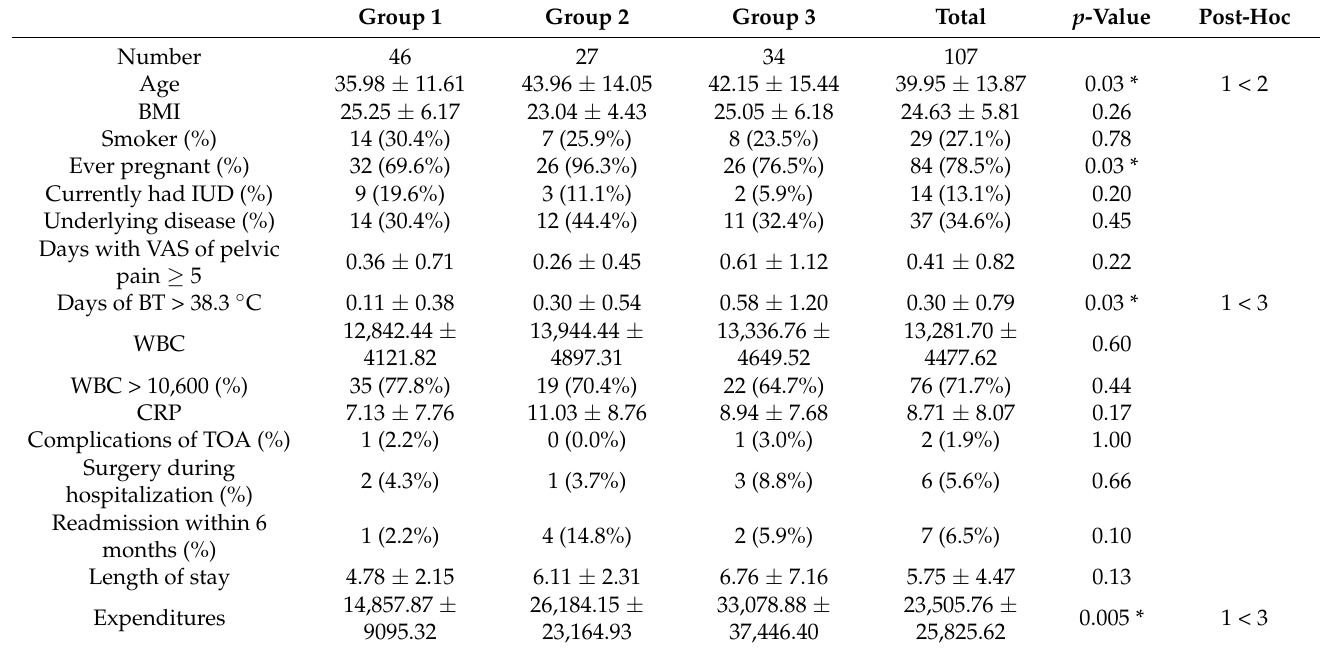
Table 1. Basic characteristics of patients in the three groups ( n = 107).